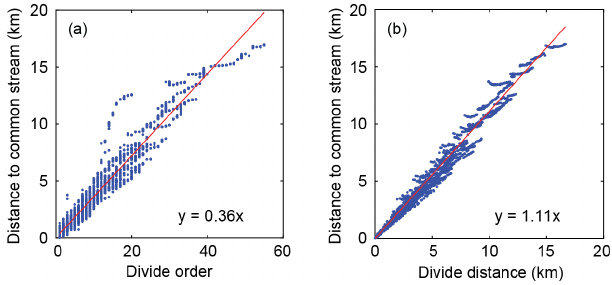
Figure 9. Distance to common stream location by (a) divide order and (b) divide distance for 100 randomly chosen divide edges per divide order within the Big Tujunga